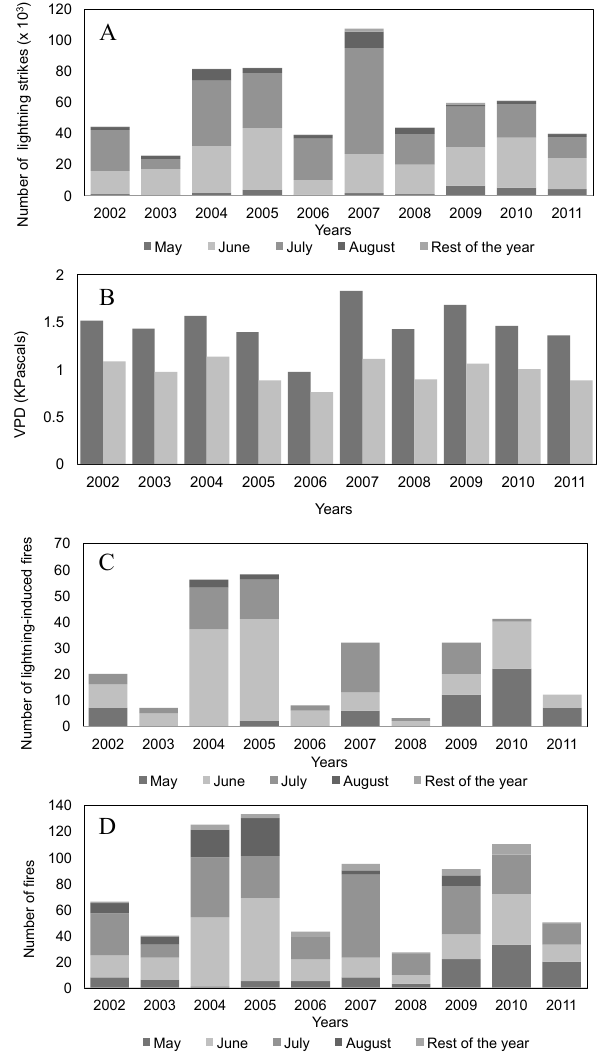
Figure 3. (A) Annual number of lightning strikes from ALDN dis- aggregated by month in the period 2002–2011; (B) Average VPD values for lightning strikes leading to fire ignitions (dark grey) and average VPD values for all other lightning strikes (light grey). (C) Annual number of lightning-induced fire start dates disaggregated by month in the period 2002–2011. (D) Annual number of fires fire start dates disaggregated by month during 2002–2011.